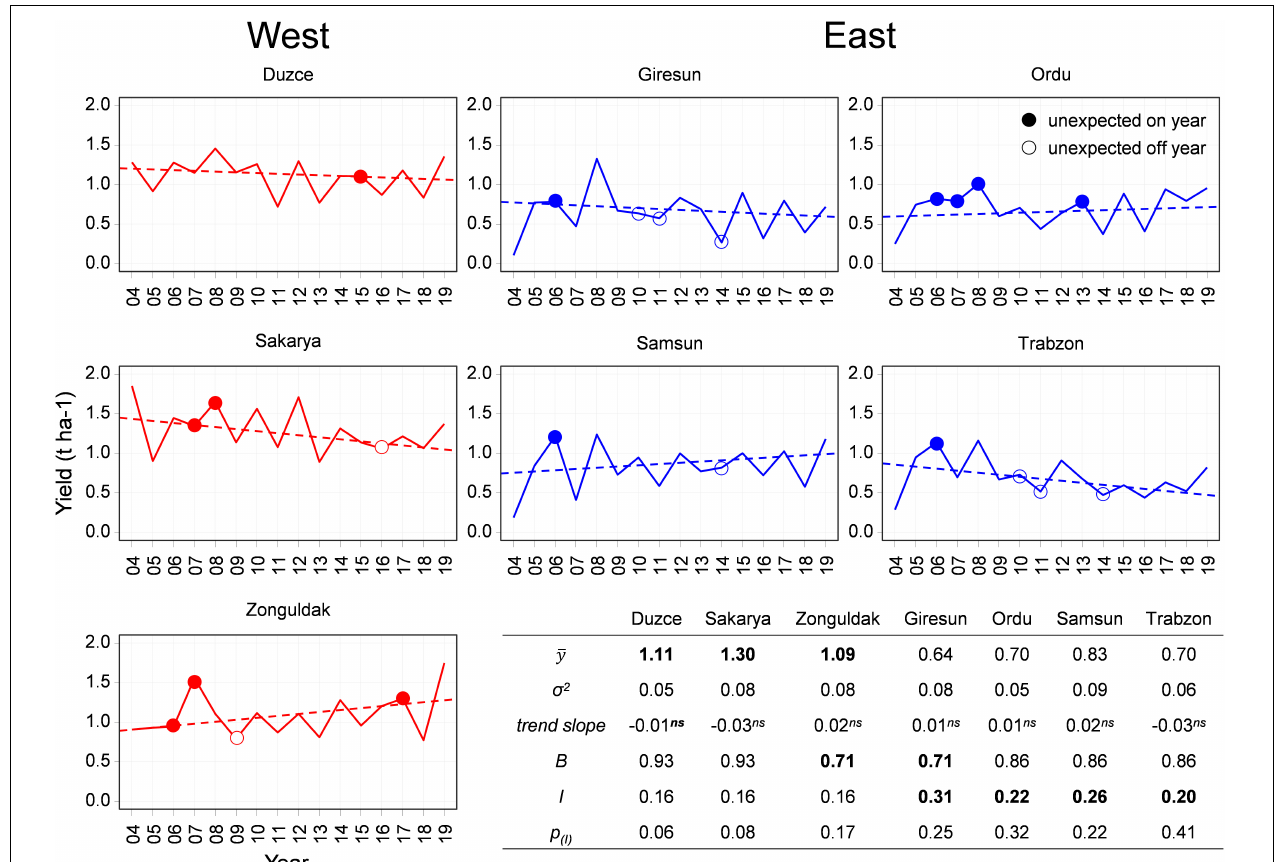
FIGURE 2 | The plots show yield data in seven Turkish municipalities (red continuous line for Eastern municipalities, blue for Western municipalities) in the period 2004–2019. Unexpected on and off years are marked with a circle. The yield trend is reported as a dashed line. The table shows the statistics of the series: mean yield ( y ) and variance ( σ 2 ), trend slope, bienniality index (B), alternate bearing intensity (I) and